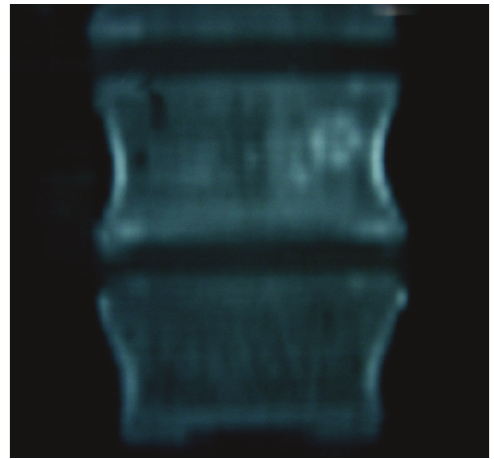
Figure 3 - Tomographic reconstruction demonstrating the tumor niche and adjacent bone sclerosis.